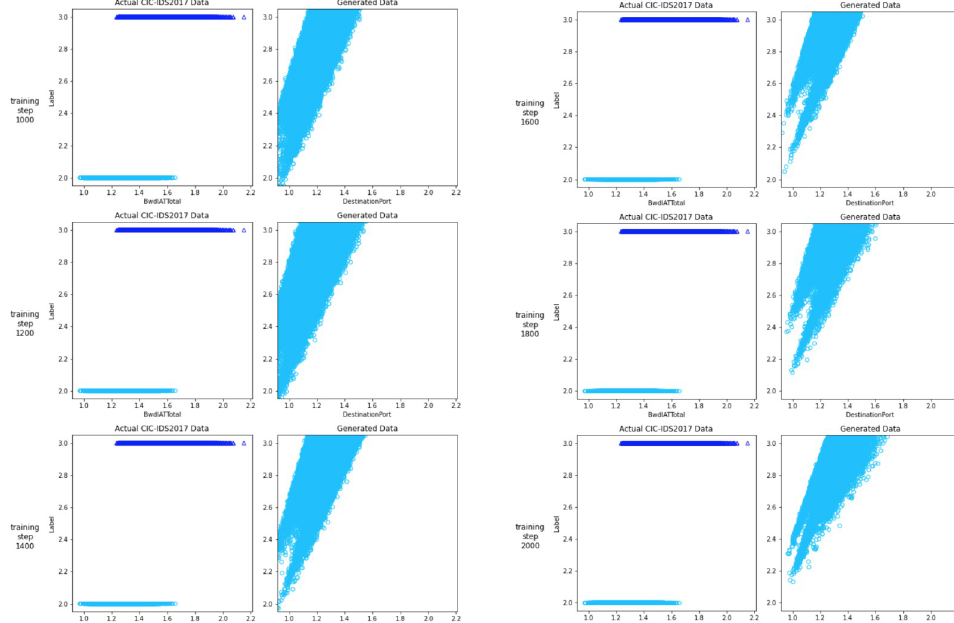
Fig 5. Comparison of GAN